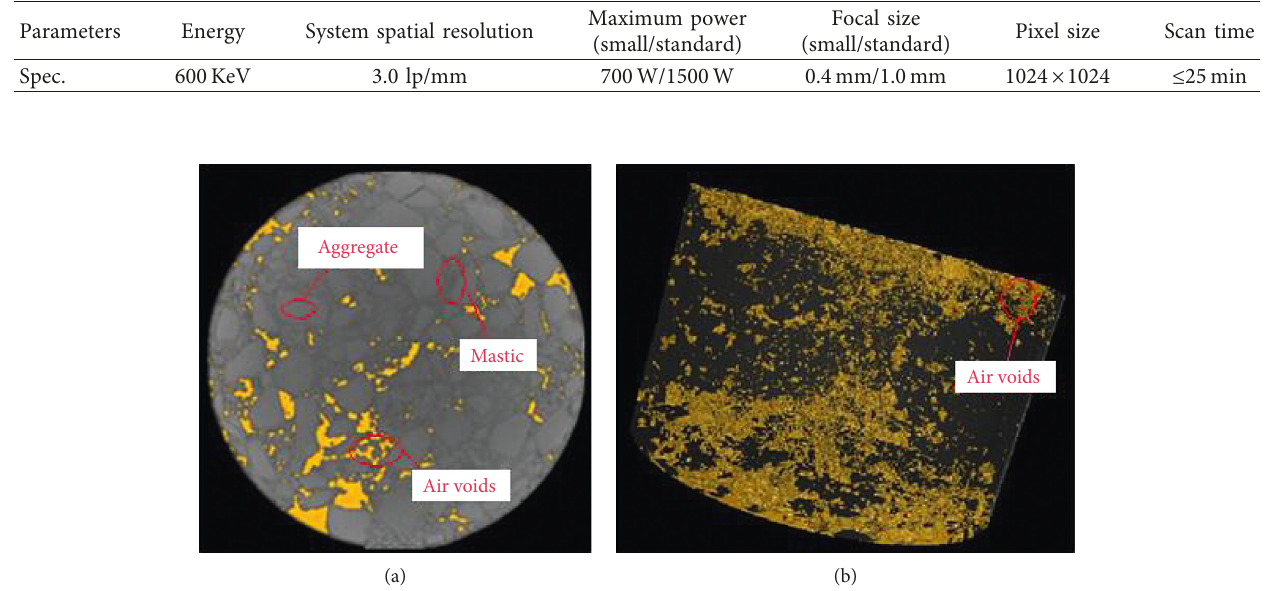
Figure 2: The schematic diagram of the industrial computed tomography (CT) system. Table 9: Specifications and scanning parameters of the industrial CT.